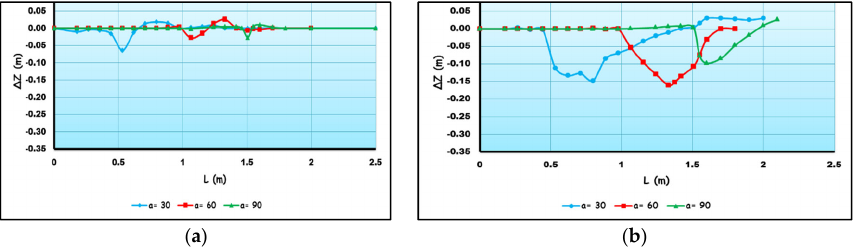
Figure 6. Comparison of erosion depth changes in the outer wall of a 90-degree bend for the Froude number values of 0.17 and 0.28 and W − Weir installation at 30, 60, and 90 degrees. ( a ) Froude number = 0.17. ( b ) Froude number = 0.28.